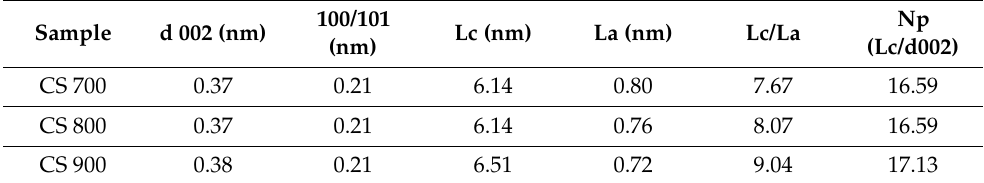
Table 1. Interlayer spacing and microcrystallite size with reference to temperature.